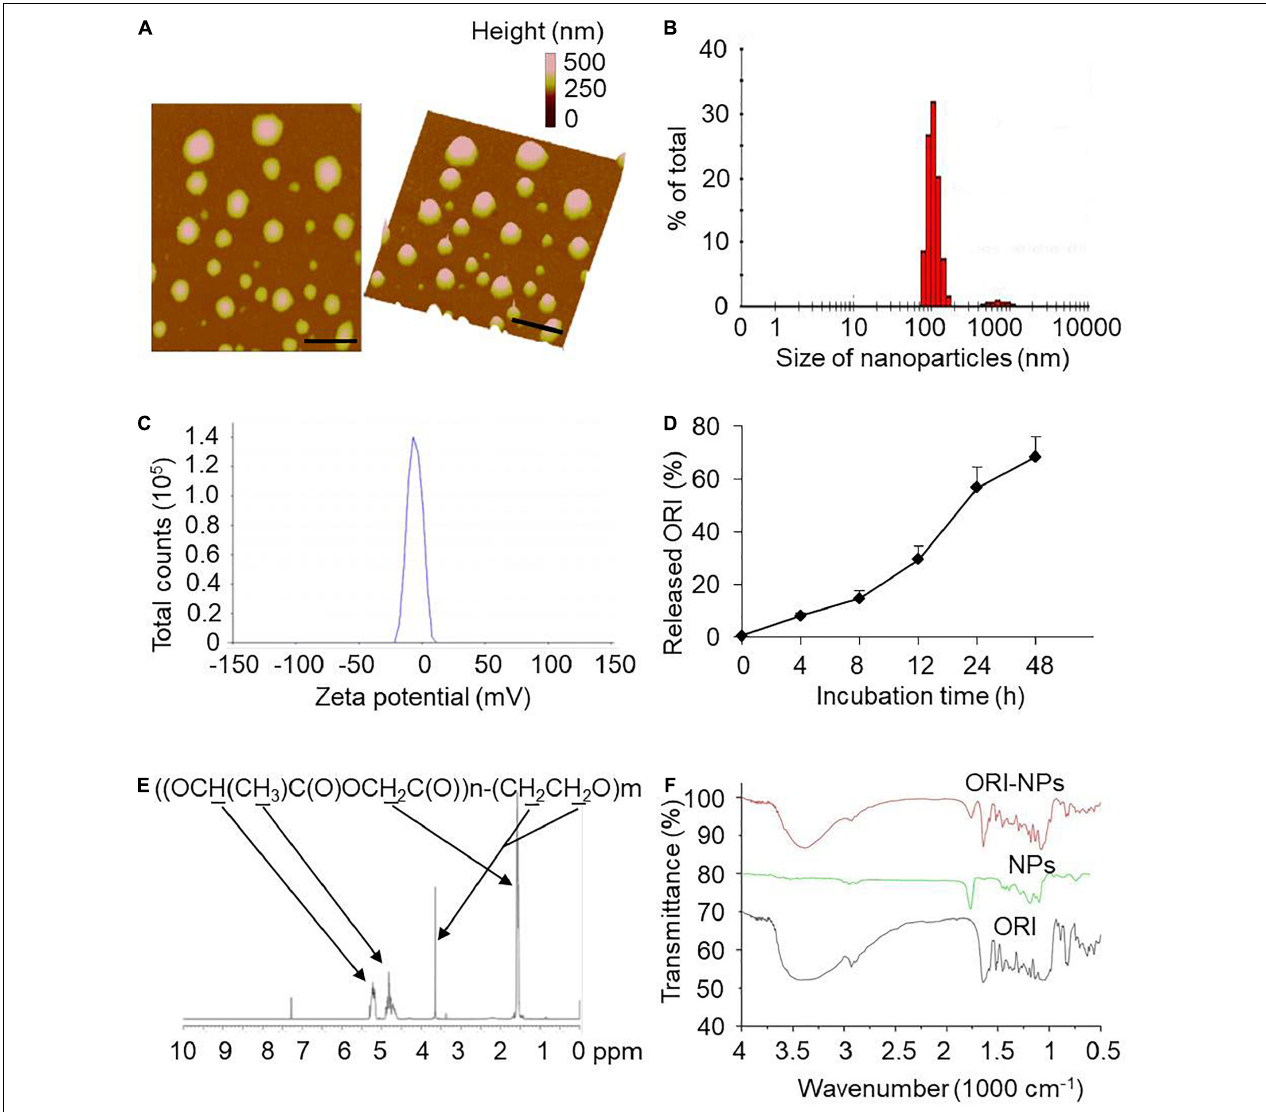
FIGURE 1 | Characterization of ORI-NPs. (A) Representative atomic force microscope images of ORI-NPs. (B) Size distribution of ORI-NPs. (C) The zeta potential distribution analysis of ORI-NPs. (D) In vitro release kinetics of ORI from ORI-NPs. (E) The FTIR spectra of PEG–PLGA NPs, ORI-NPs and ORI. (F) 1H NMR spectrum of the synthesized PEG–PLGA–NPs. The copolymer was dissolved in CDCl3 and characterized by 1H NMR at 400 Hz for determining its number-average molecular weight. Characteristic peaks as marked in the graphs.